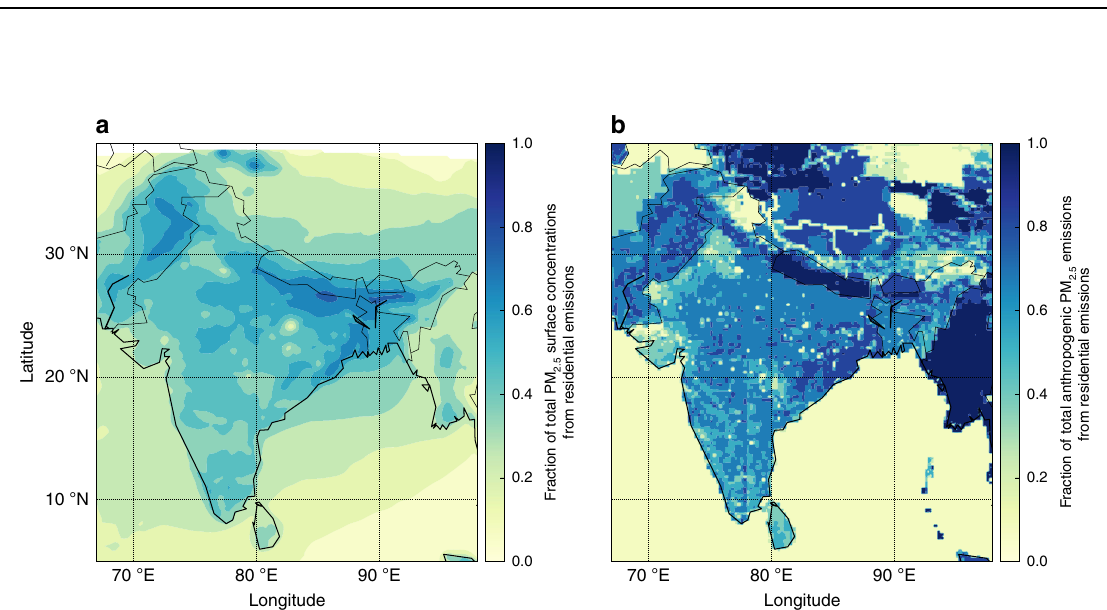
Reduction to population-weighted PM 2.5